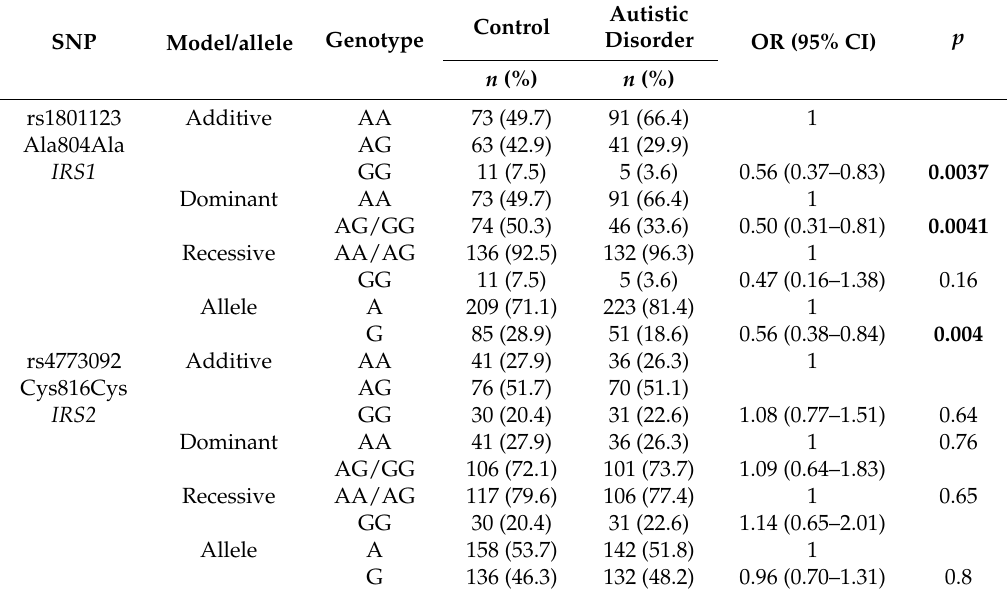
Table 2. Multiple logistic regression analysis of IRS1 and IRS2 polymorphisms in patients with autistic disorder and control